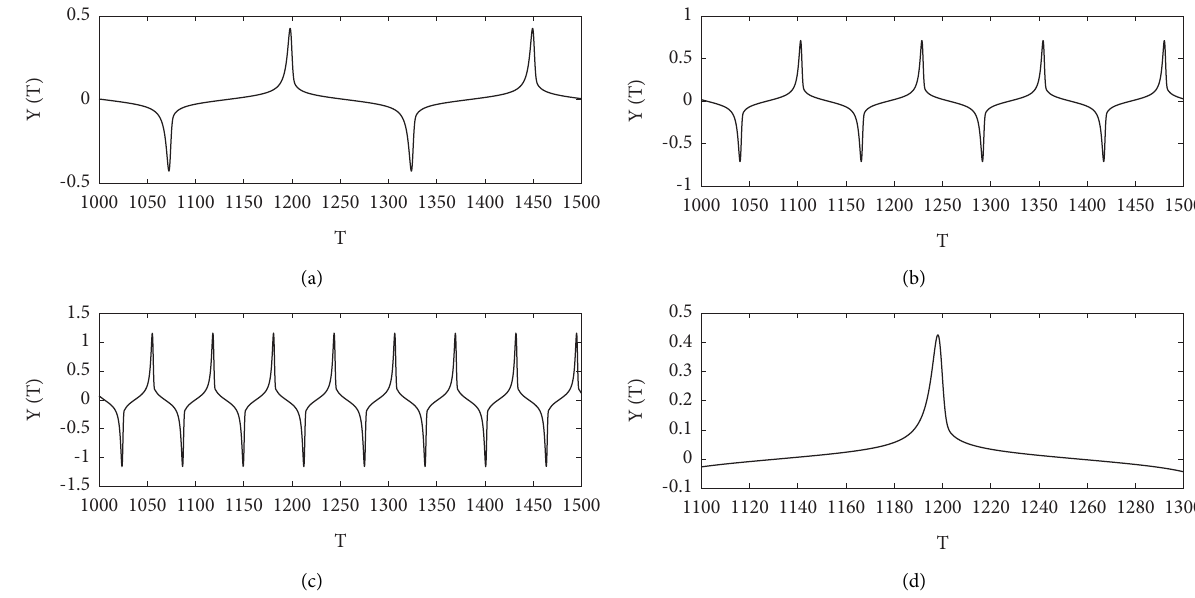
Figure 6: Periodic busting oscillations in the plant-wind system for parameters F � 27, ξ � 2 . 5, and α � 0 . 675: (a) ω � 0 . 025; (b) ω � 0 . 05; (c) ω � 0 . 1; (d) zooming of (a).